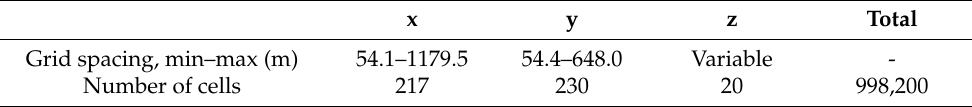
Table 4. Mesh of